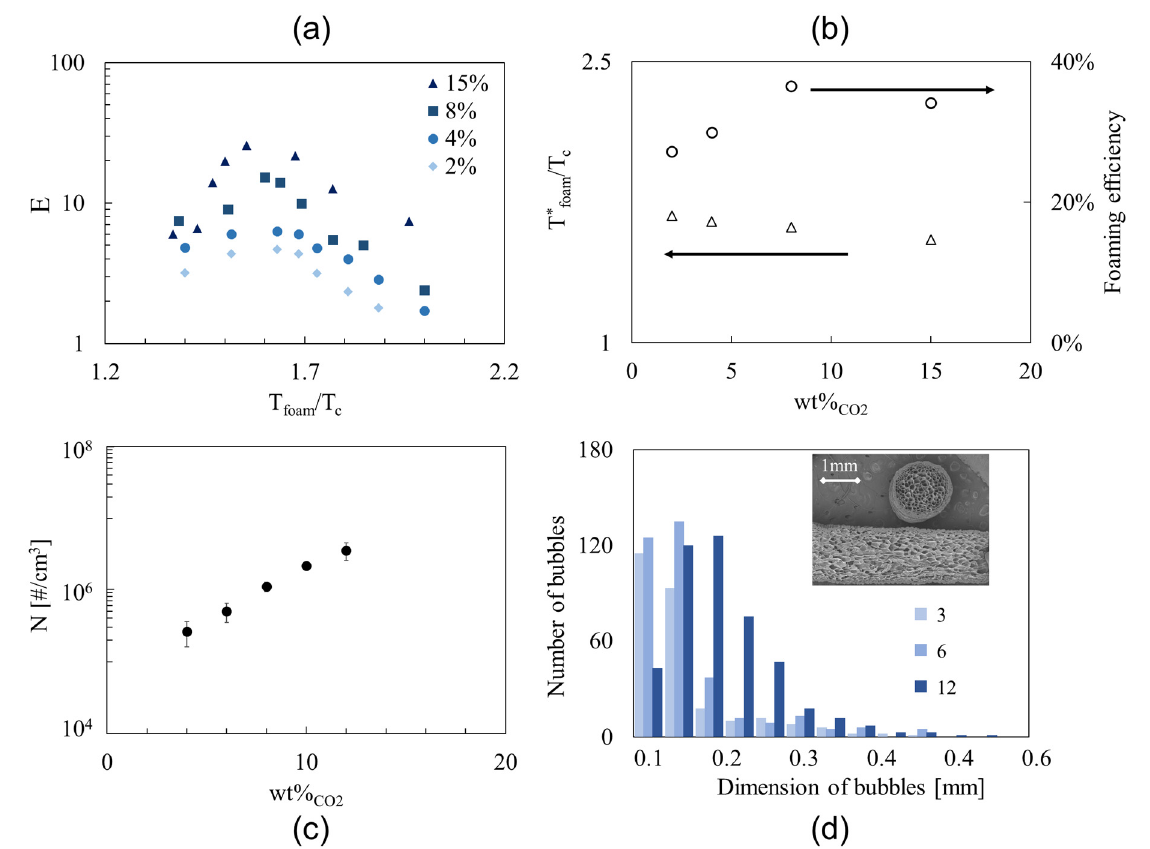
Figure 2. ( a ) Effects of foaming temperature and CO 2 concentration on foam density; ( b ) Effects of CO 2 concentration on the foaming temperature maximizing the expansion ratio (triangles) and on the foaming efficiency (circles); ( c ) Effect of CO 2 concentration on bubble density at 𝑇 (cid:2916)(cid:2925)(cid:2911)(cid:2923)∗ /𝑇 (cid:2913) ; ( d ) Bubble size distribution for three foamed strands obtained at T foam = 1.7 T c and 3, 6, and 12 wt% CO2 (see legend). Insert: SEM picture of the cross and longitudinal sections of a foamed strand at 6 wt%CO 2 .